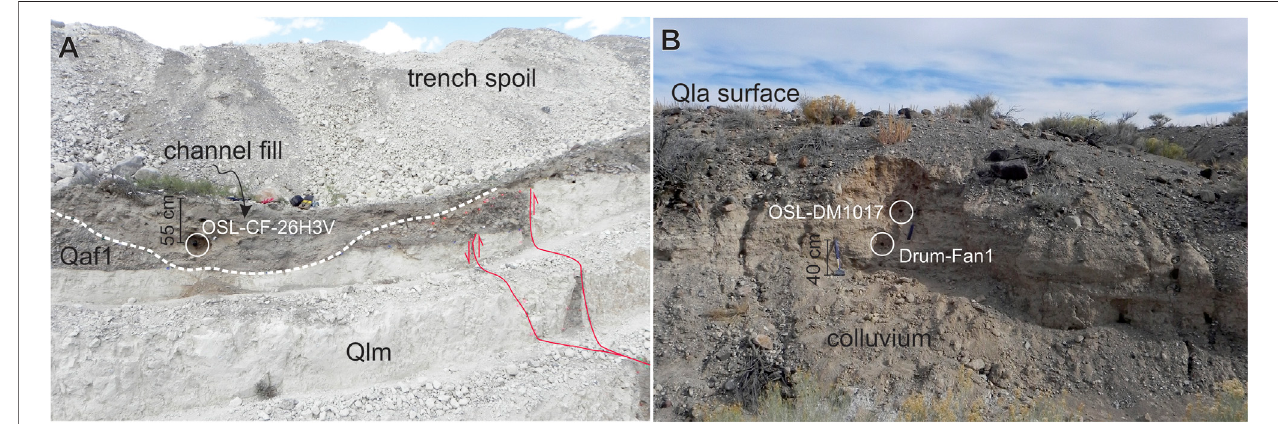
FIGURE 3 | Annotated sample locations for optically stimulated luminescence (OSL) samples. (A) Photograph of a paleoseismic trench exposure showing faulting of pre- and post- Lake Bonneville strata. Qlm — lake marl deposited during the transgressive phase of Lake Bonneville (c. 20 – 30 ka). Qaf1 — alluvial fan gravel and sand deposited during and after the over fl owing stage of Lake Bonneville/Lake Provo, following the fall of the Bonneville highstand at 18.5 ka to the elevation of the Provo shoreline.SampleOSL-CF-26H3Vwascollectedfromsiltsandsands depositedinachannelonthehangingwallofthefault(red)andgivesanindicationoftheage of youngest and most active deposition within map unit Qaf1. (B) Two samples (OSL-DM1017 and Drum-Fan1) were collected from sand beds within pre-Lake Bonneville alluvial fan sands and gravel (map unit Qla). Refer to Figure 2 for sample locations.